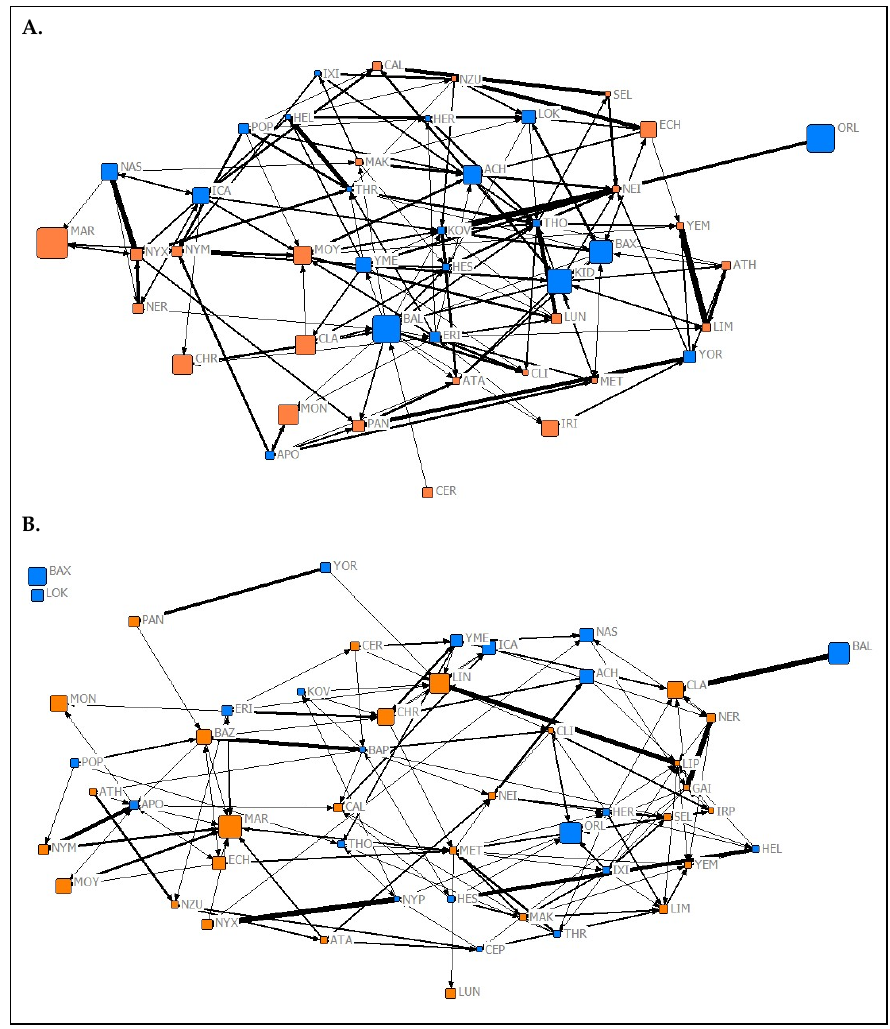
Figure 2. Graphical representations of the observed affiliation networks from ( A ) Summer 2019 and ( B ) Spring 2020 of captive P. livingstonii . Nodes are labelled with their assigned three letter codes. Blue nodes denote male individuals, and orange denote females. The size of each node corresponds to the age in years of the individual during respective data collection periods with older individuals being represented by a larger node. The width of each tie increases with the weight of the edge. Non-metric geo-distances with node repulsion were used to create the layout, meaning nodes with more similar ties are closer together and nodes that are more central to the network are placed closer to the centre of the